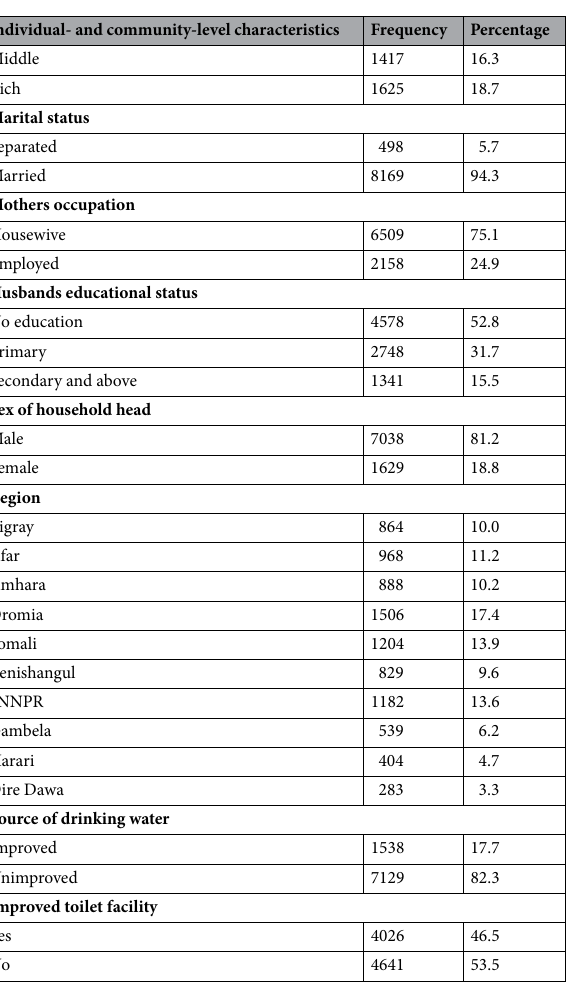
Table 2. Socio-demographic and obstetric characteristics of the study respondents EDHS 2016. ANC Antenatal Care, SNNPR Southern nations, nationalities, and people region, TT Tetanus